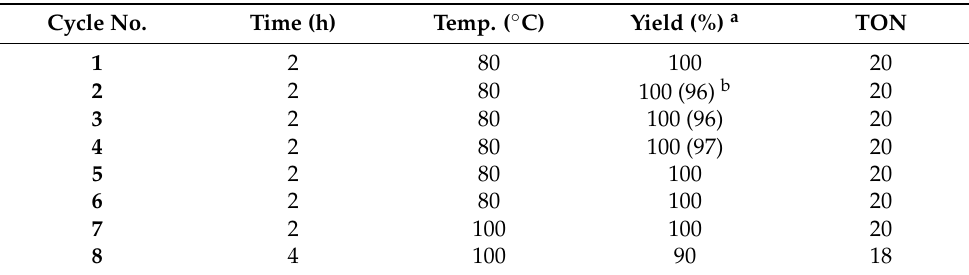
reaction. a Measured by GC/MS; b isolated yield in parenthesis.